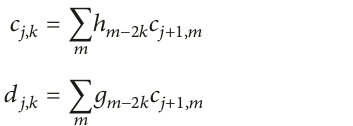
of the signal onto the spaces of scaling function 𝜙 𝑗,𝑘 (t)